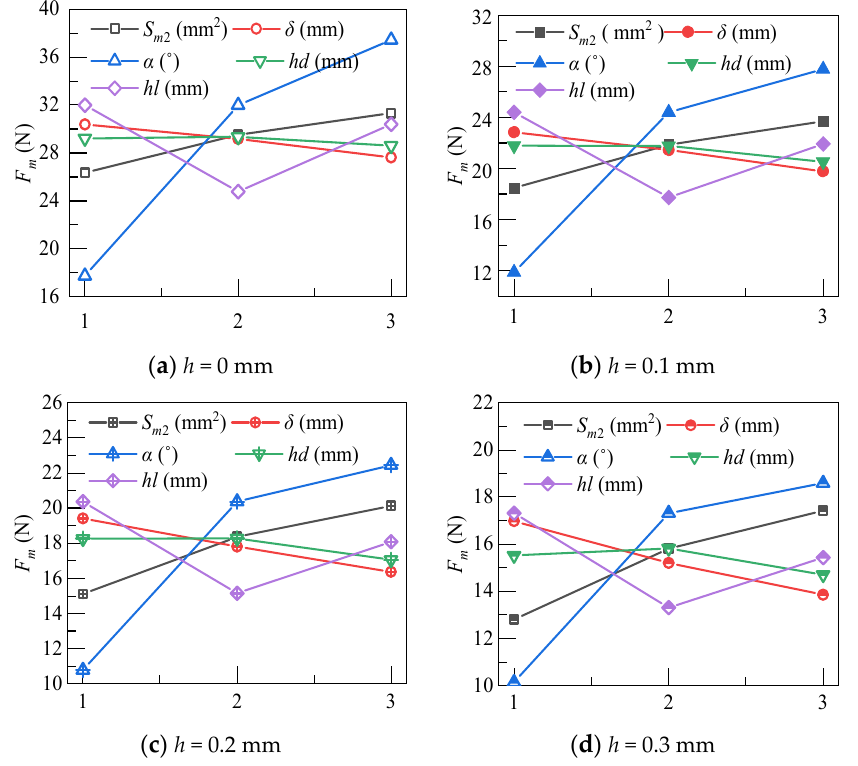
Figure 14. The influence trend chart of five optimization variables on static electromagnetic force. The optimal structural design factors combination for the maximum static electromagnetic force is S m 2 (3) δ (1) α (3) hd (2) hl (1). Meanwhile, the optimized HFSV prototype was manufactured and tested. In Figure 15, the experimental value is compared with the simulation under different working air gap. The experiment results are in good agreement with the simulation ones. The results before and after optimization are shown in Table 7. It can be found that the static electromagnetic forces are increased by 60.65%, 61.56%, 51.04% and 42.48%, when the working air gap position is 0 mm, 0.1 mm, 0.2 mm and 0.3 mm, respectively.